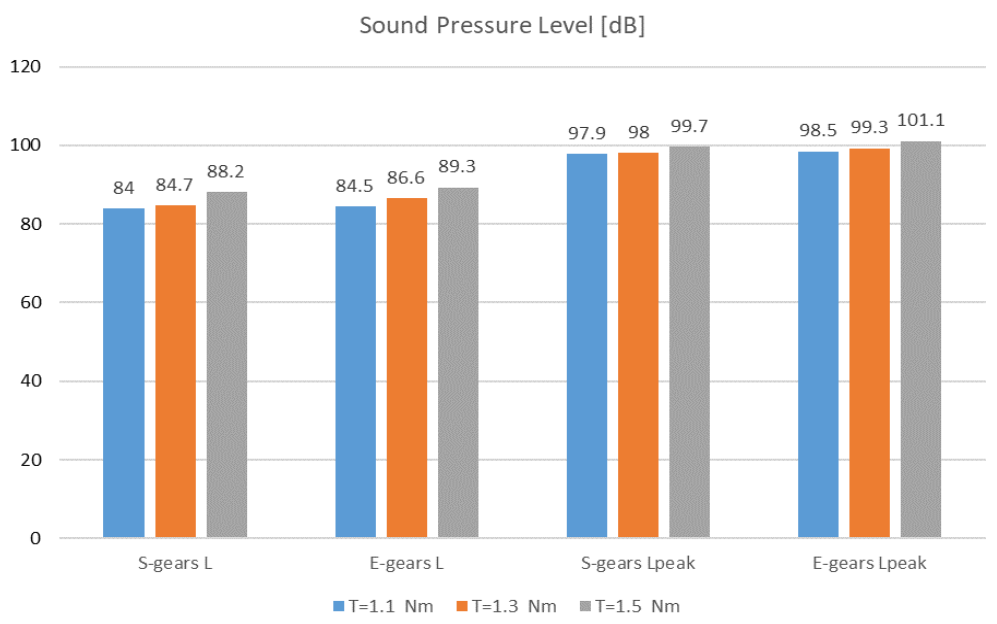
Polymers 2022 , 14 , x FOR PEER REVIEW Figure 7. Sound pressu re levels L and L peak of E-gears and S-gears for different torques. Figure 7. Sound pressure levels L and L peak of E-gears and S-gears for different torques.